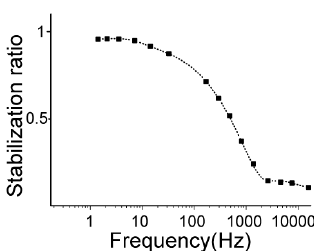
Figure 4. Frequency response of the bubble-based fluidic stabilizer obtained through simulation via COMSOL Multiphysics. COMSOL